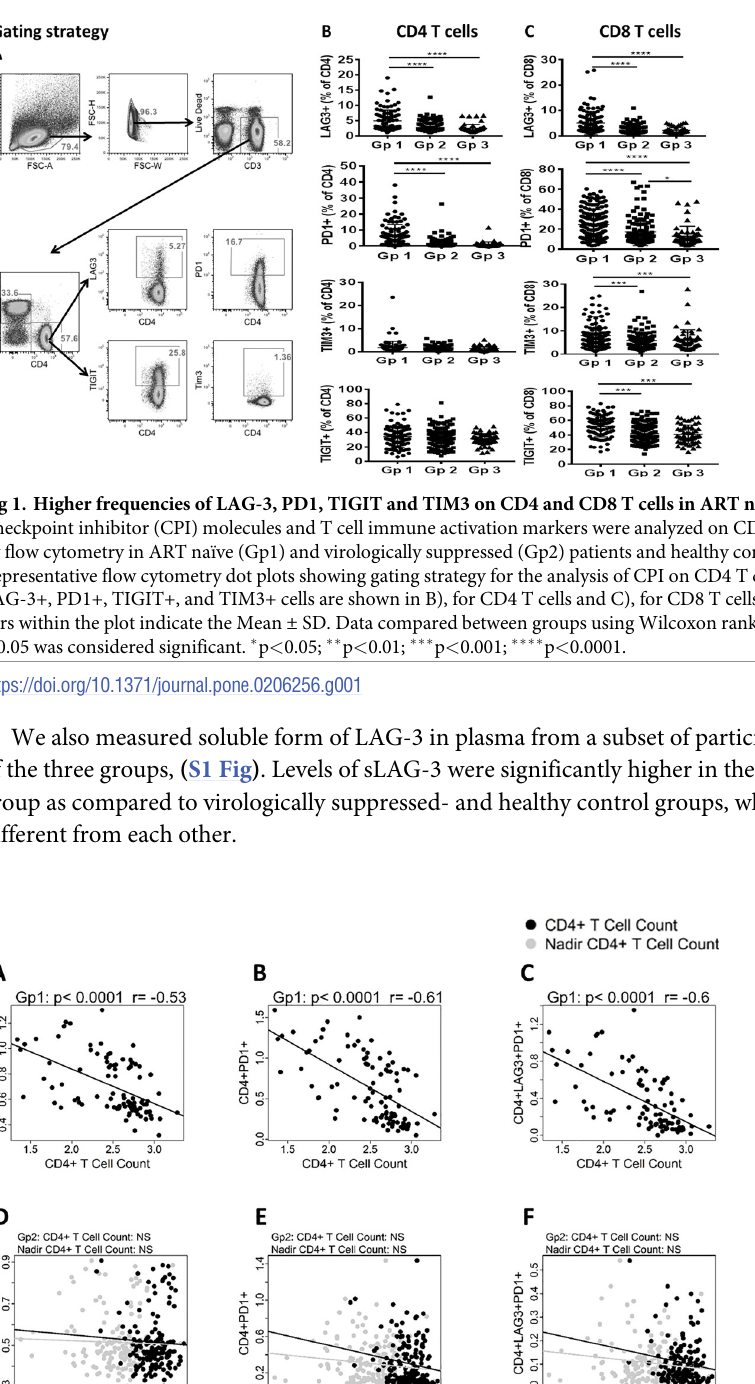
Fig 2. Absolute CD4 numbers correlate with CPI molecule expression on CD4 T cells in ART na ï ve individuals. A-C: ART na ï ve Gp1 patients. Linear regression analysis shows correlation between CD4 T cell counts at study entry with A), LAG-3+CD4; B), PD1+CD4 and C), LAG-3+PD1+ CD4 T cells. D-F: Virologically suppressed Gp2 patients. Linear regression analysis shows correlation between CD4 T cells count (black circles) and nadir CD4 T cells (grey circles) with D), LAG-3+CD4; E), PD1+CD4 and F), LAG-3+ PD1+ CD4 T cells. Pearson correlation was performed based on data distribution; a p value of < 0.05 was considered as